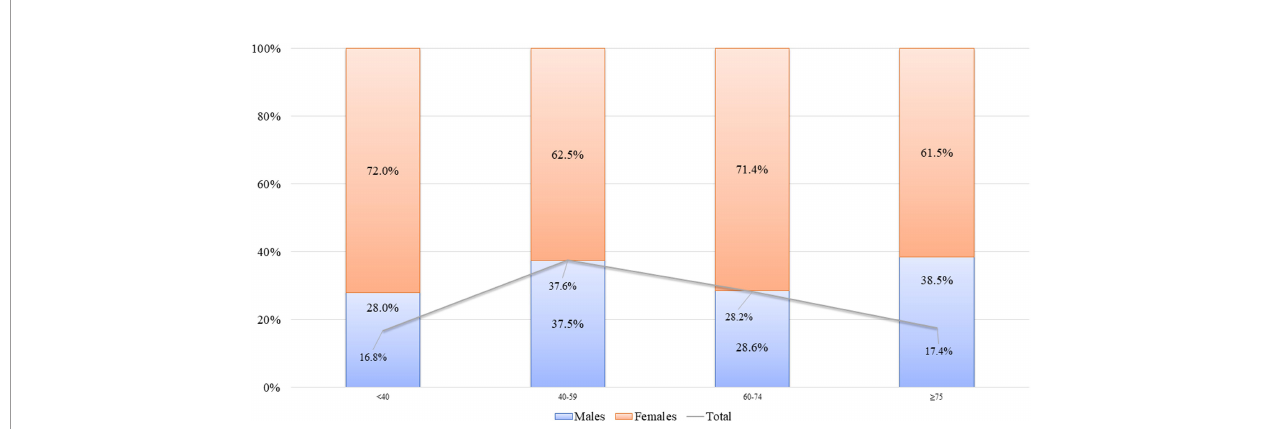
FIGURE 1 | Age distribution of patients, total and by sex. Proportions of male and female patients for each age class are reported in bars. Total percentage of each age class is also reported (gray